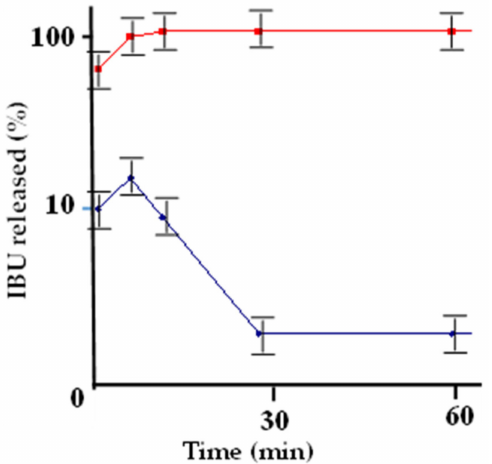
Figure 10. Semi-log plot of IBU profile release in a simulated gastro-intestinal medium of C-LDH-IBU ( (cid:7) ) and LDH-IBU ( (cid:4) ) as a function of time.